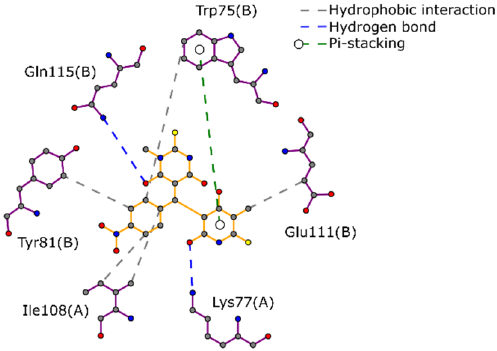
Figure 1. 2D interaction diagram between compound D4, an inhibitor, and TIM Eh on the interface. Once the D4 inhibitor was studied, 1466 FDA drugs were docked against TIM Eh